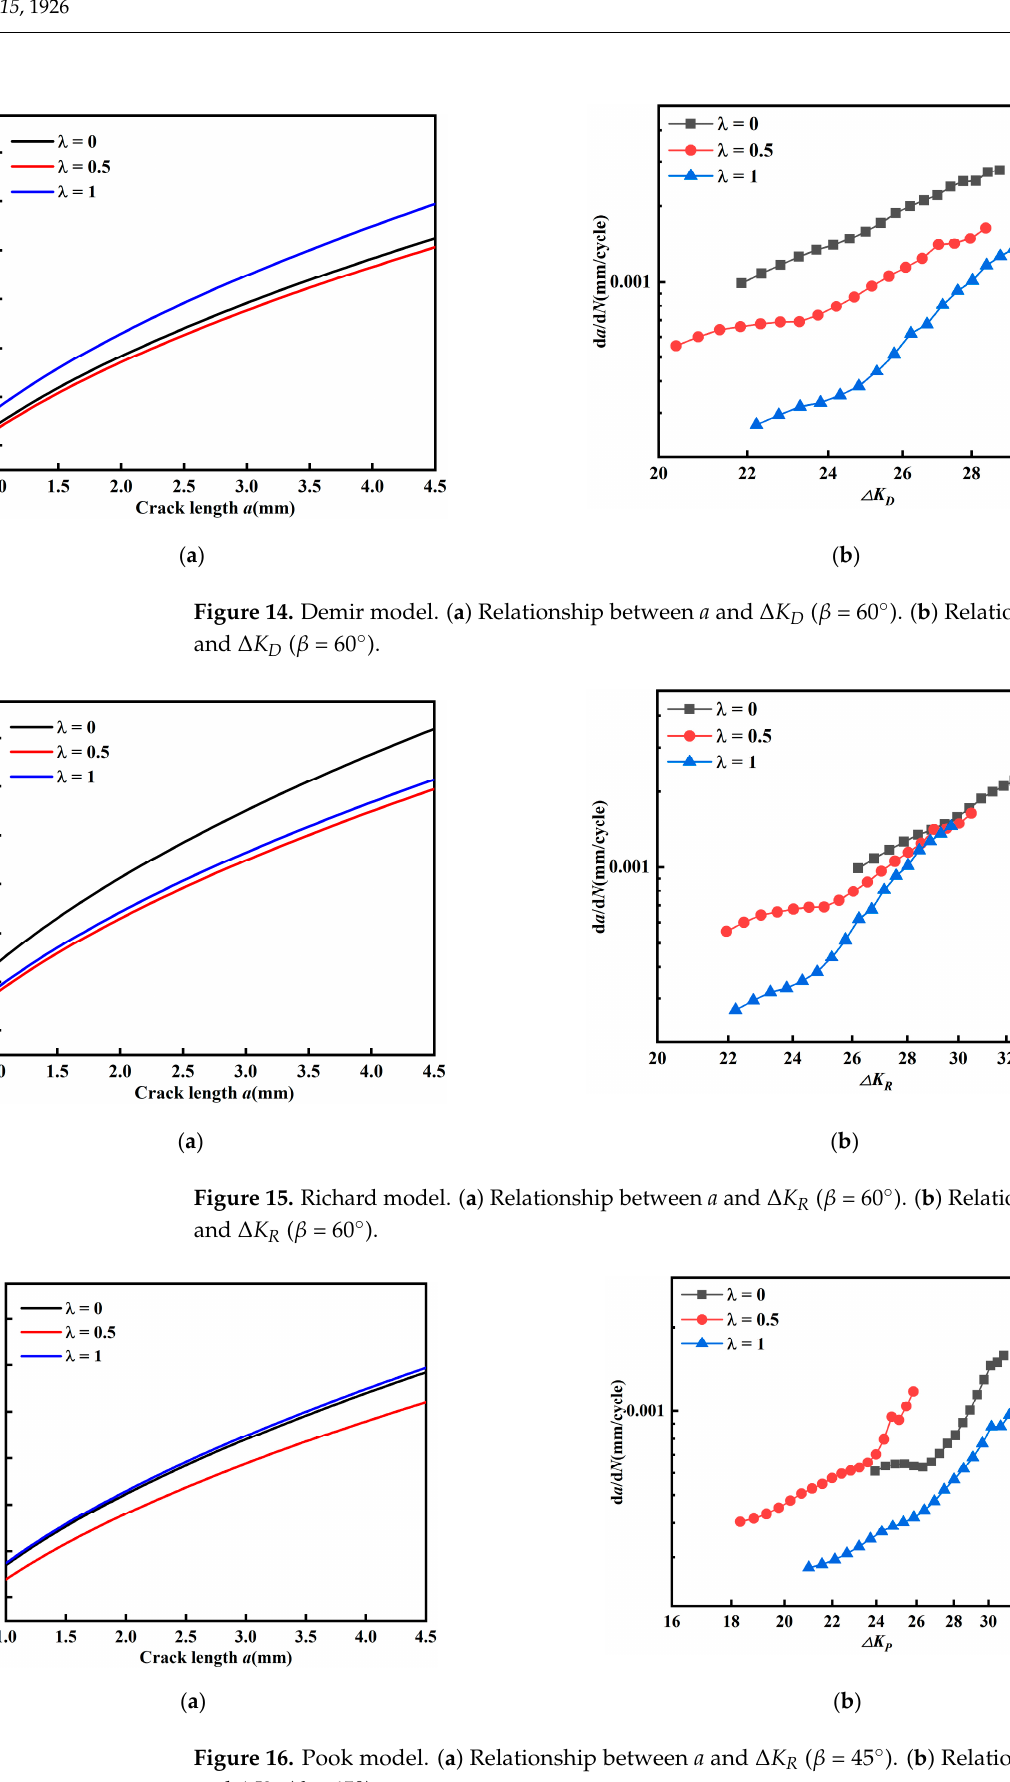
( d ) Figure 17. Relationship between crack length, equivalent stress intensity factor amplitude and da/dN . ( a ) Relationship between a and △ K v ( β = 60°), ( b ) relationship between a and △ K v ( β = 45°), ( c ) relationship between △ K v and da/dN ( β = 60°), and ( d ) relationship between △ K v and da/dN ( β = 45°).